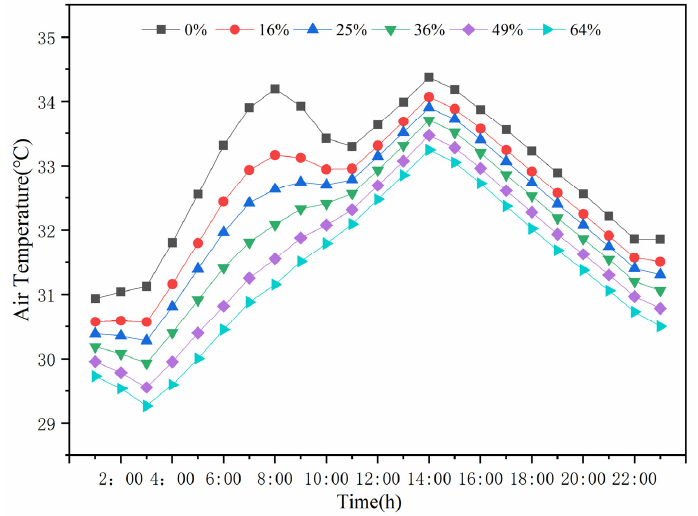
tions of 36%, 49%, and 64%, the temperature began to increase gradually after 3:00 and reached its highest value at 14:00. reached its highest value at 14:00.